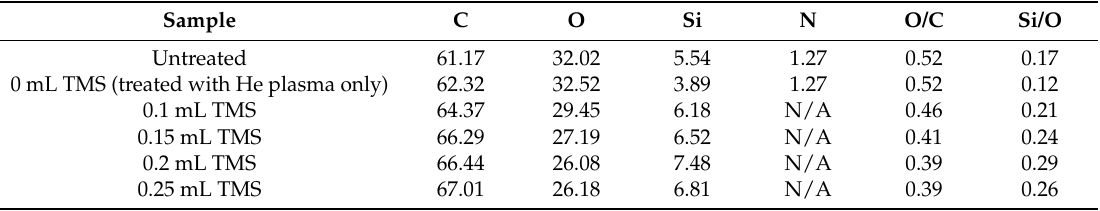
Figure 11. XPS deconvoluted C1s peak in ( a ) untreated sample and ( b ) plasma-modified rayon flock synthetic leather (treatment parameters: amount of TMS = 0.2 mL; flow rate of helium = 12.5 LPM; discharge power = 50 W; jet distance = 10 mm; treatment time = 30 s). Table 6. Atomic percentage and ratio of rayon flock synthetic leather surface.